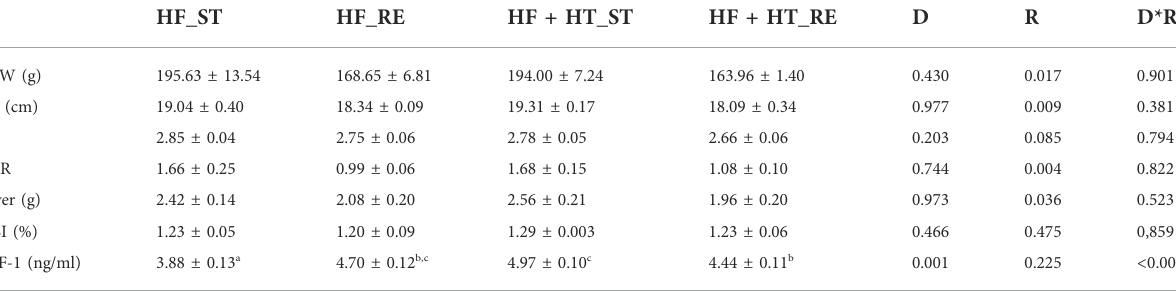
TABLE 3 Somatic indices and IGF-1 plasma levels of gilthead sea bream juveniles fed with a high-fat diet in the absence (HF) or presence (HF + HT) of hydroxytyrosol (0.52 g HT/kg feed), at a standard (ST) (3% biomass/tank) or restricted ration (RE) (40% daily reduction) for 8